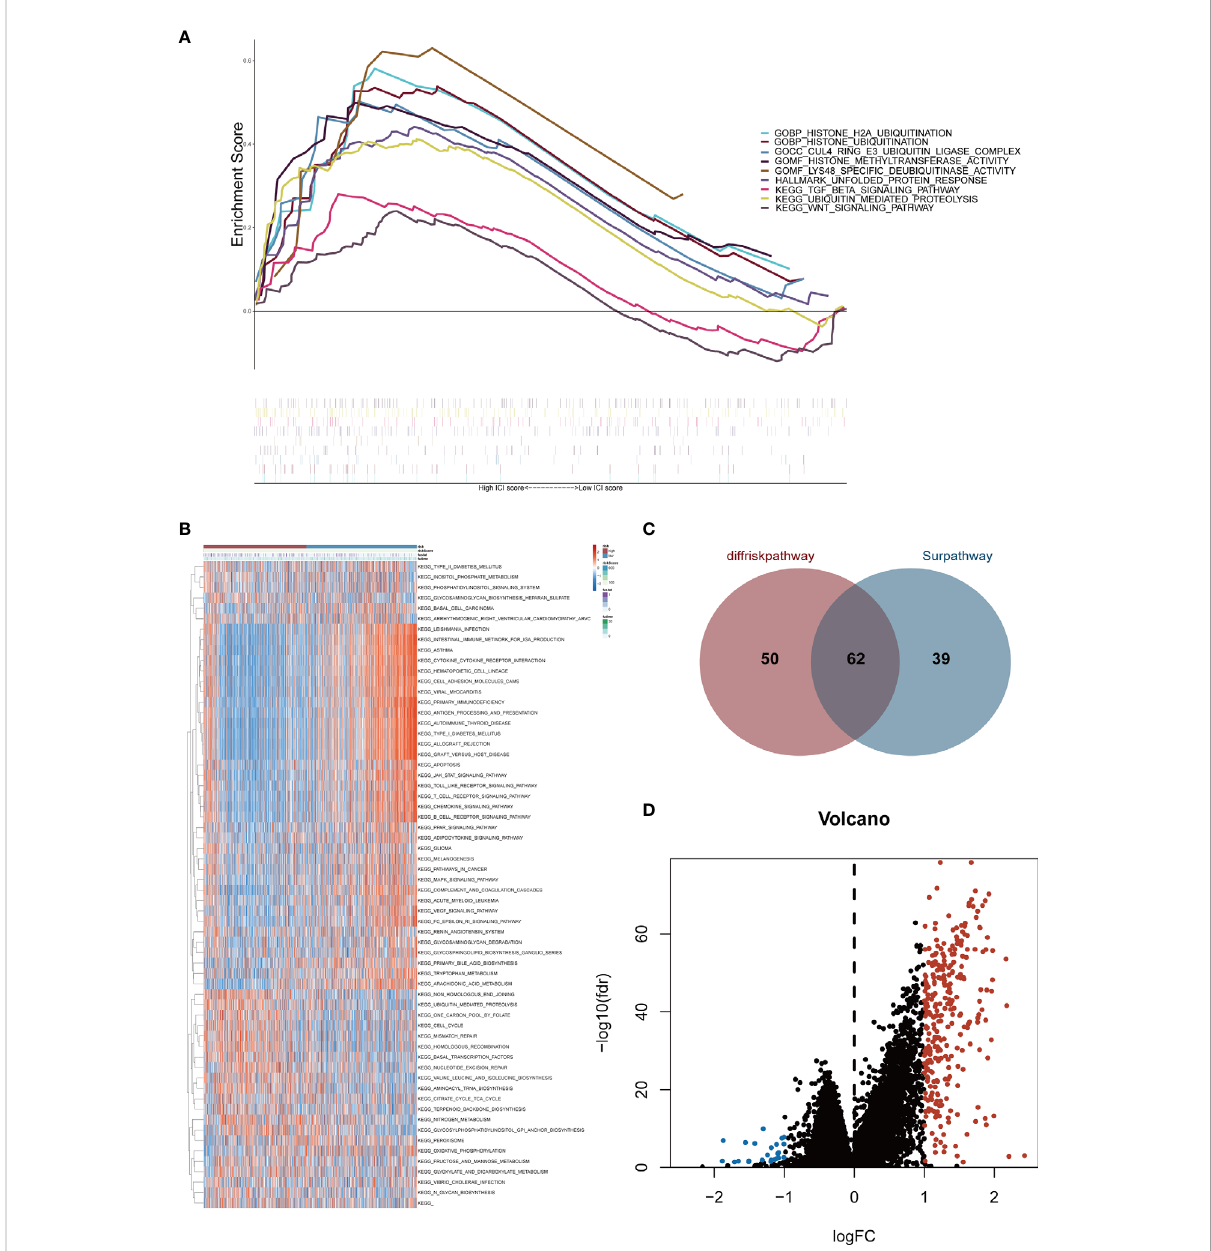
FIGURE 4 (A) Gene set enrichment analysis (GSEA) illustrated the functional enrichment and pathway enrichment in the high-risk subgroup. (B) Gene set variation analysis (GSVA) enumerated difference of enriched pathways between high-/low-risk subtypes. (C) Venn diagram of quantity statistics for KEGG pathways correlated with risk score and survival time. (D) Volcano plot depicted differential expression genes in high-/low-risk subtypes (|logFC| >1 and FDR<0.05). KEGG, Kyoto Encyclopedia of Genes and